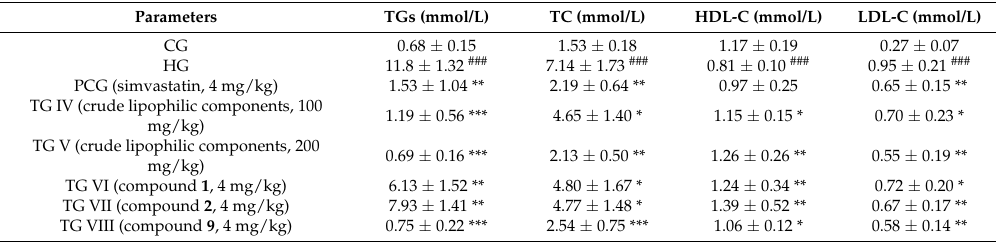
Table 3. Effect of the crude lipophilic components and compounds 1 , 2 , 9 on plasma lipid levels in Triton WR-1339-induced hyperlipemic rats after 24